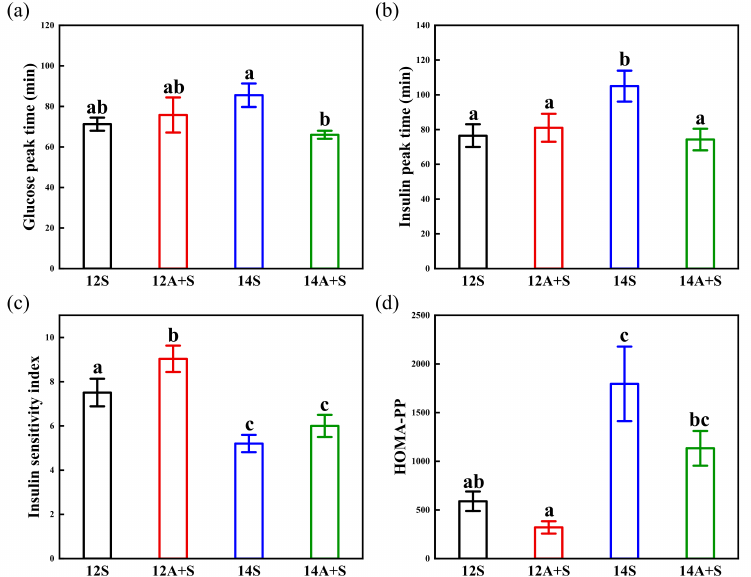
Figure 4. Glucose peak time ( a ), insulin peak time ( b ), insulin sensitivity index ( c ) and